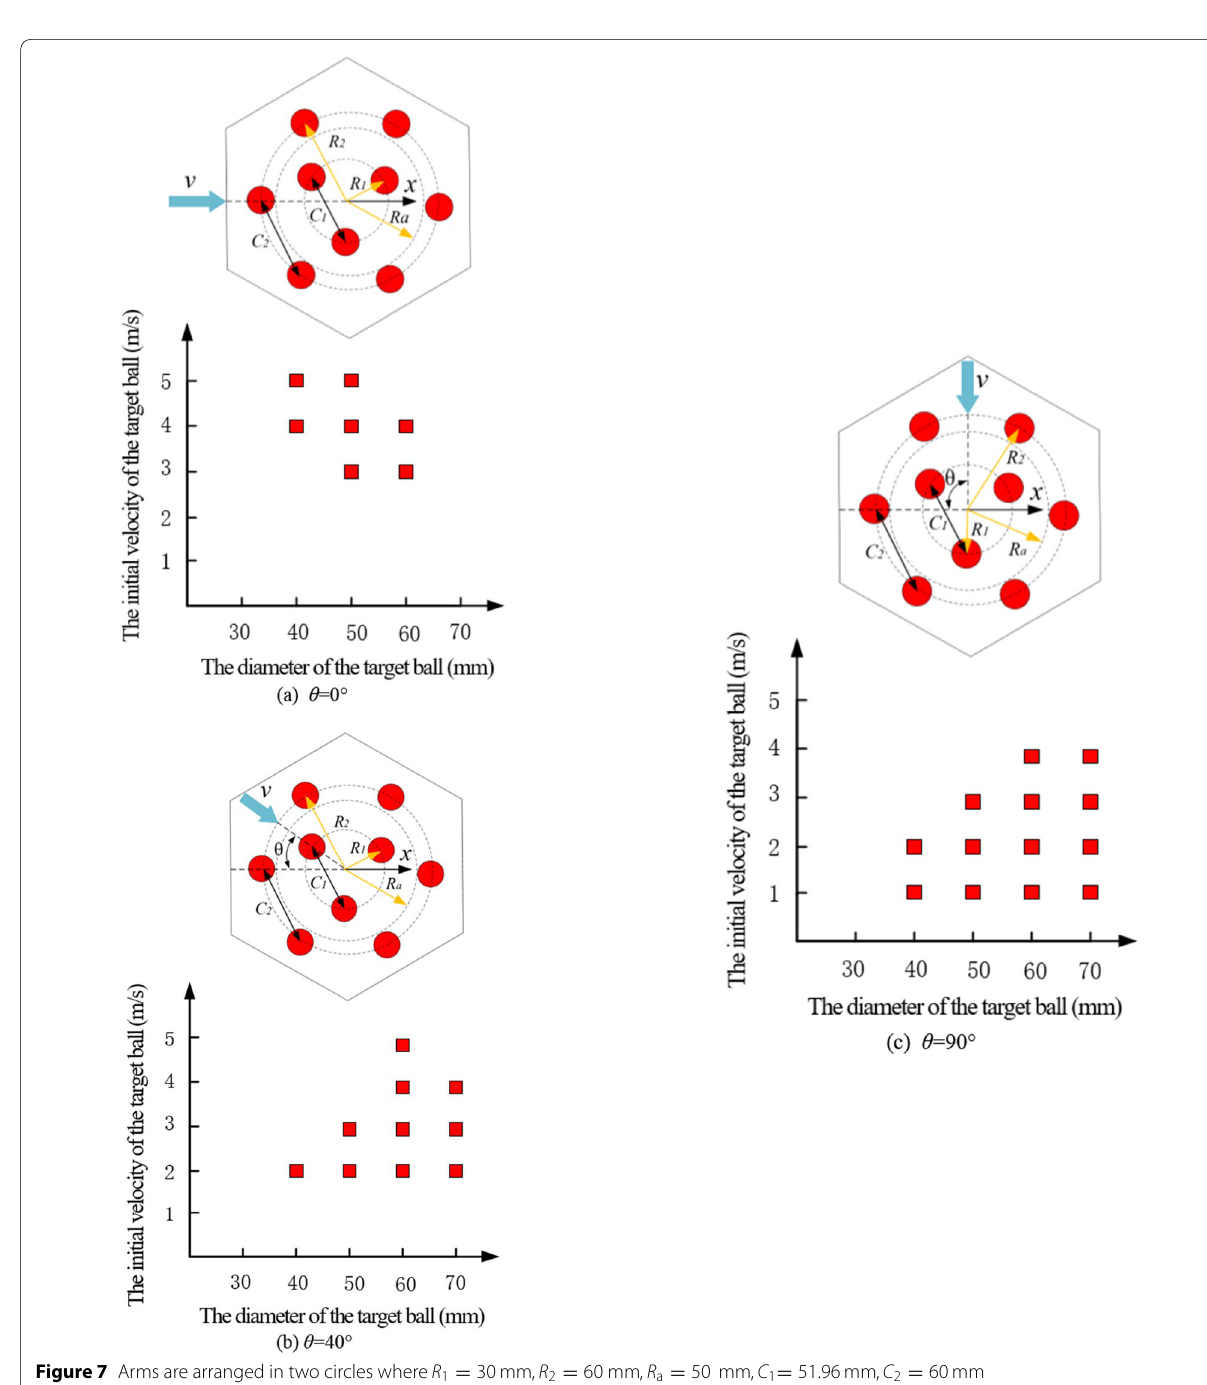
Figure 7 Arms are arranged in two circles where R 1 = 30mm , R 2 = 60 mm , R a = 50 mm , C 1 = 51.96mm , C 2 =